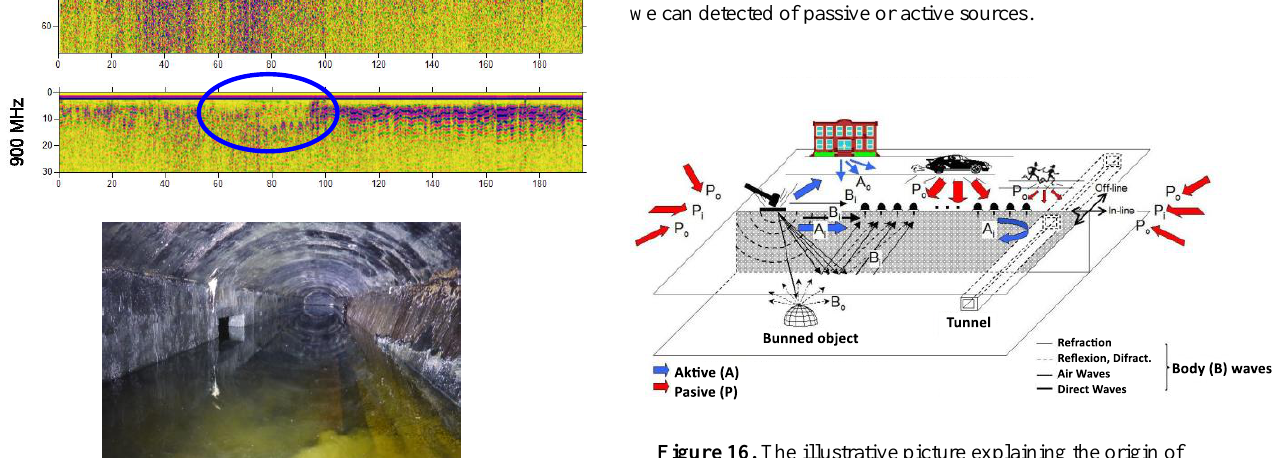
Figure 16. The illustrative picture explaining the origin of complex seismic images created as the sum of active and passive seismic sources. Taken from open Figure 15. The GPR measurement detected hidden water reservoir.